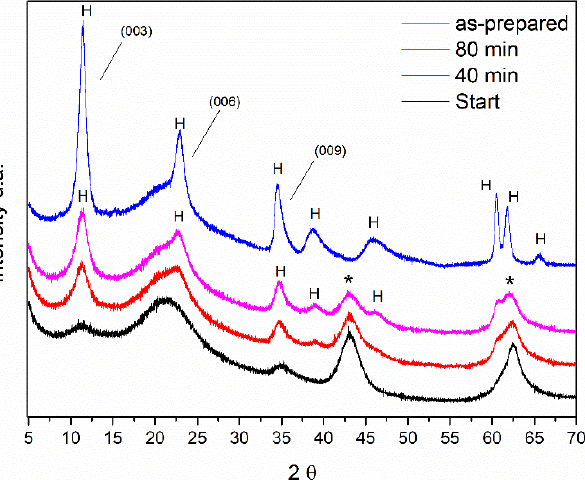
Figure 2. X-ray diffractograms obtained in situ during the rehydration process with steam H 2 O for 80 min of the LDH sample after calcination at 500 ◦ C. The X-ray diffractogram plotted in blue refers to the as-prepared LDH sample, i.e., before calcination. The symbol (*) indicates the reflections belonging to the MgO phase and (H) indicates the reflections referring to the hydrotalcite phase. The plans (003), (006), and (009) characteristic of the LDH phase are also